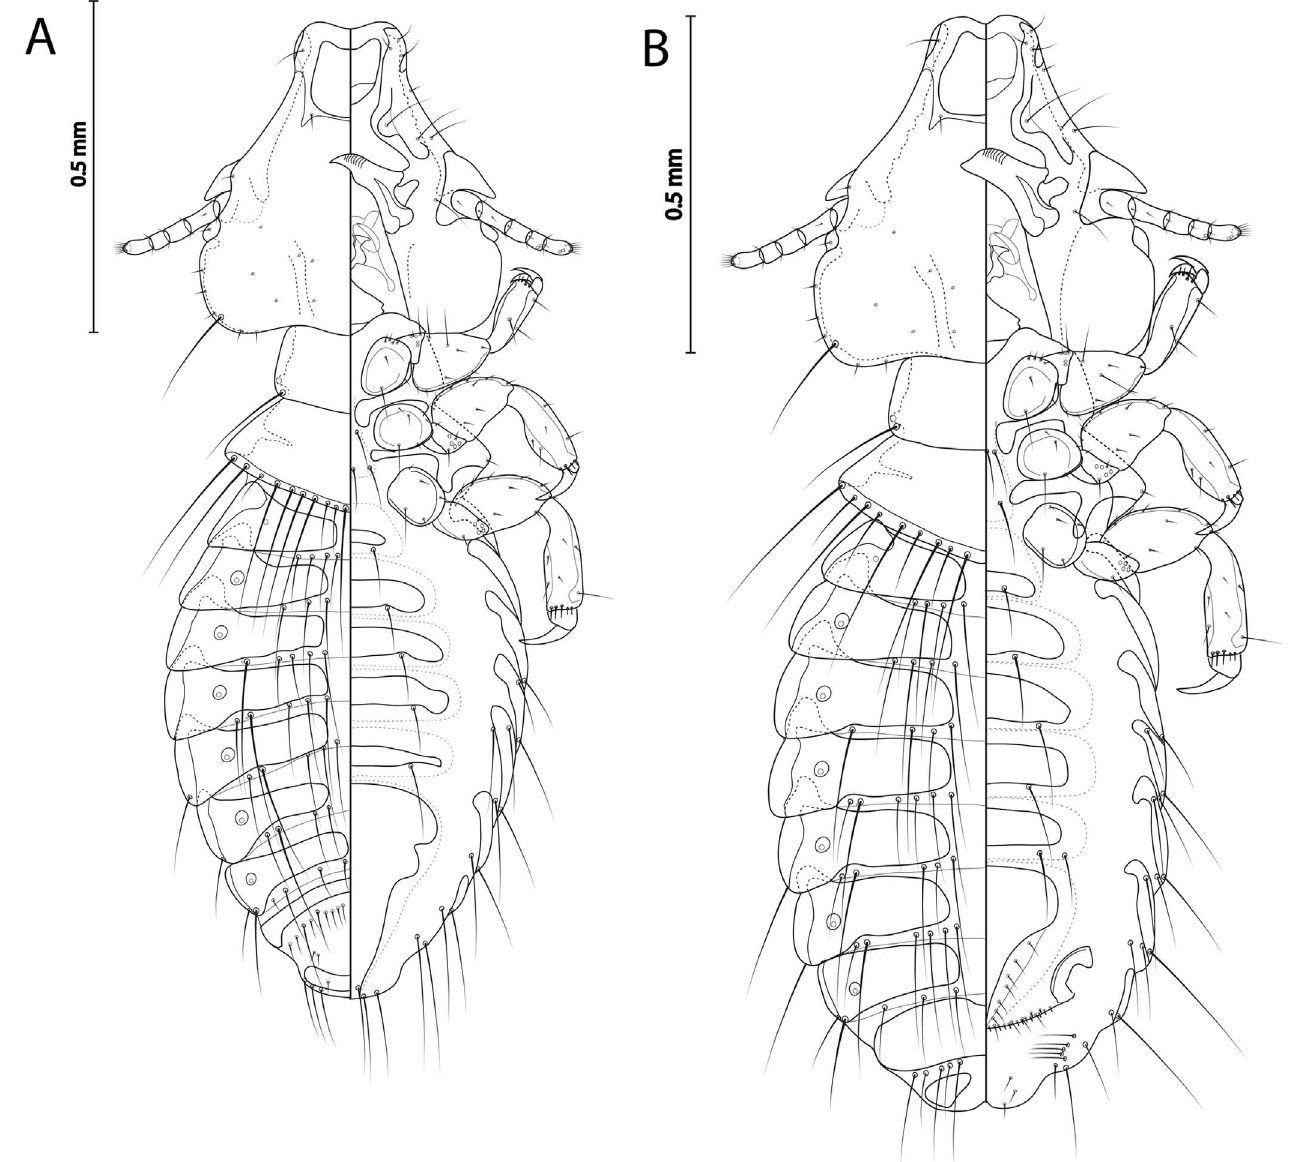
Figure 3. Sturnidoecus ex Turdus merula. (A) Male dorso-ventral view; (B) Female dorso-ventral